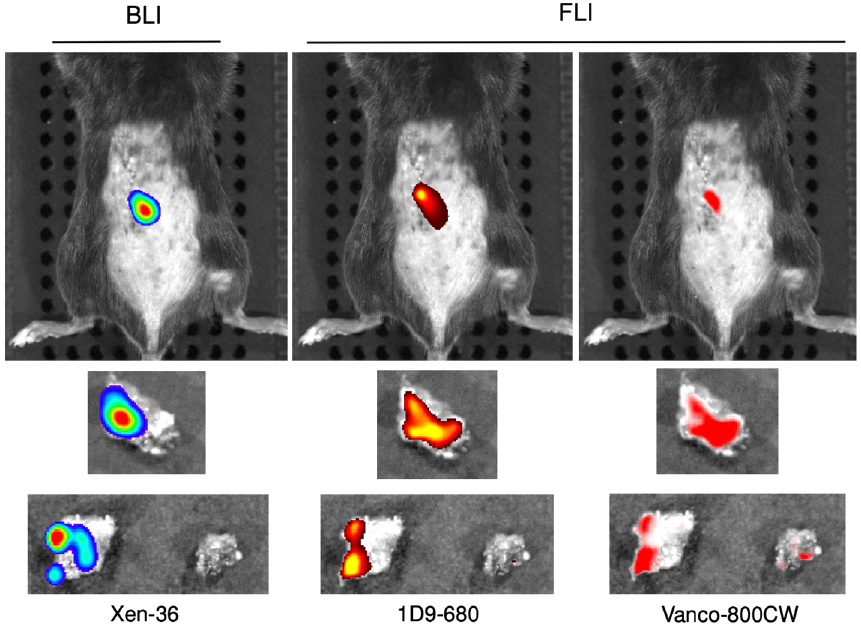
Figure 5. Bioluminescence and fluorescence imaging of infected necropsy specimen from spinal implant infection. Following necropsy of the infected tissue bed, bioluminescence and fluorescence imaging were repeated revealing co-localization of the 1D9-680 probe with infected tissue. As shown for a representative mouse, the Vanco-800CW imaging revealed co-localization with the infected necropsy specimen, but fluorescence signal was also detected on supplemental tissue without bioluminescence.